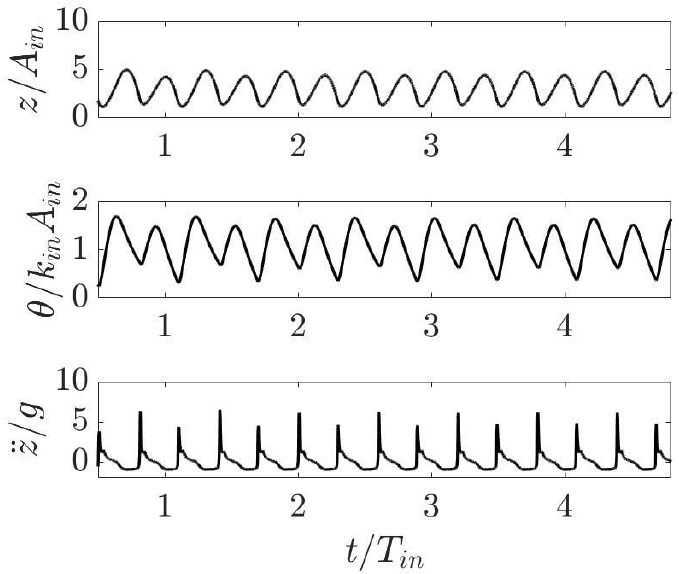
Figure 6. A sample of the responses of Model B to waves. The presented data correspond to 2𝐿 and a beam Froude number of 4.7.